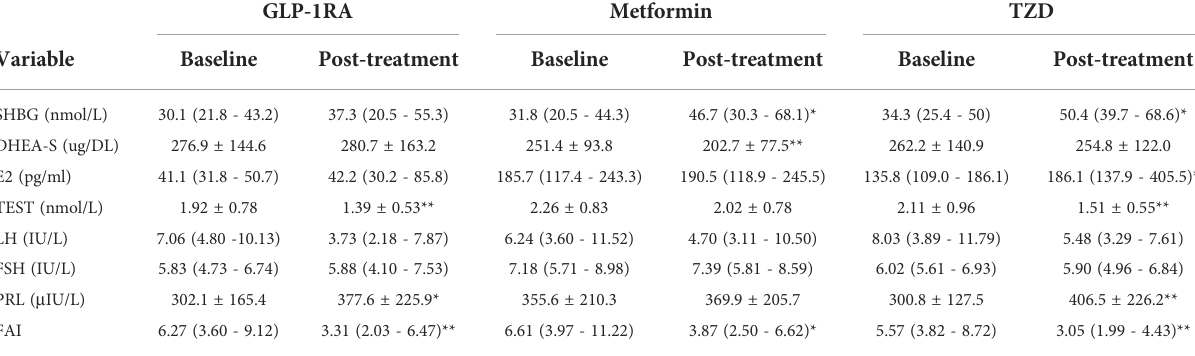
TABLE 6 Main hormone levels pre- and post-treatment with the anti-diabetes drug in PCOS